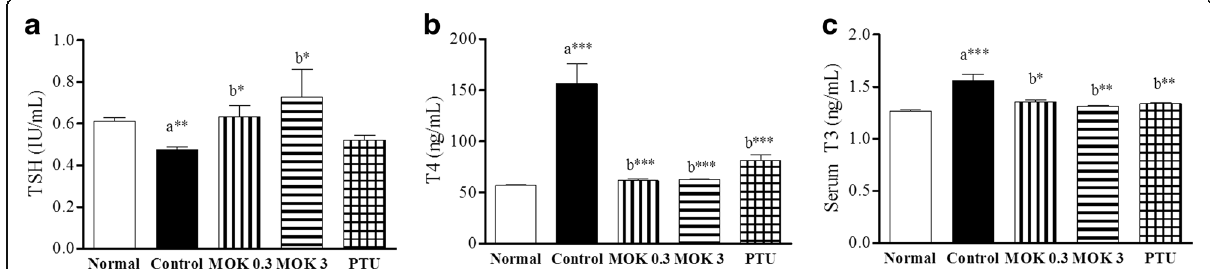
Fig. 5 Effects of MOK pharmacopuncture on the levels of thyroid hormones in LT4-induced hyperthyroidism rats. MOK pharmacopuncture was subcutaneously administered once daily for 2 weeks and measured the levels of TSH ( a ), T4 ( b ), and T3 ( b ) in the sera of rats by ELISA, respectively. Data are presented as mean±SD ( n =5 per each group). * P <0.05, ** P <0.01 and *** P <0.001 vs normal ( a ) or control ( b ). Normal, normal group; Control, LT4-induced hyperthyroidism group; MOK 0.3, MOK 0.3 mg/kg-treated group in control; MOK 3, MOK 3 mg/kg-treated group in control; and PTU, PTU 10 mg/kg-treated group as a reference